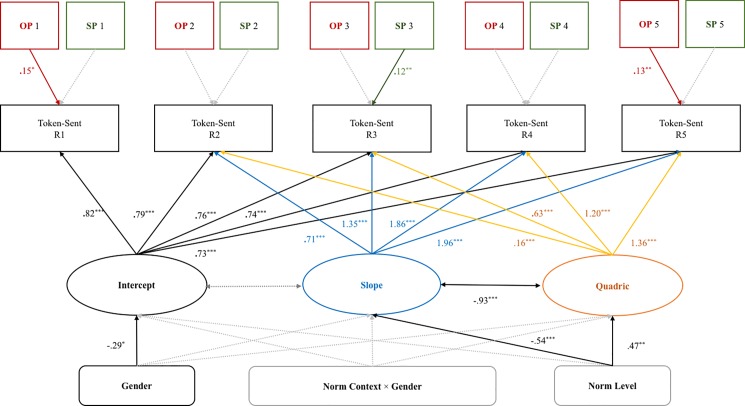
Latent growth curve model with significant standardized path coefficients.